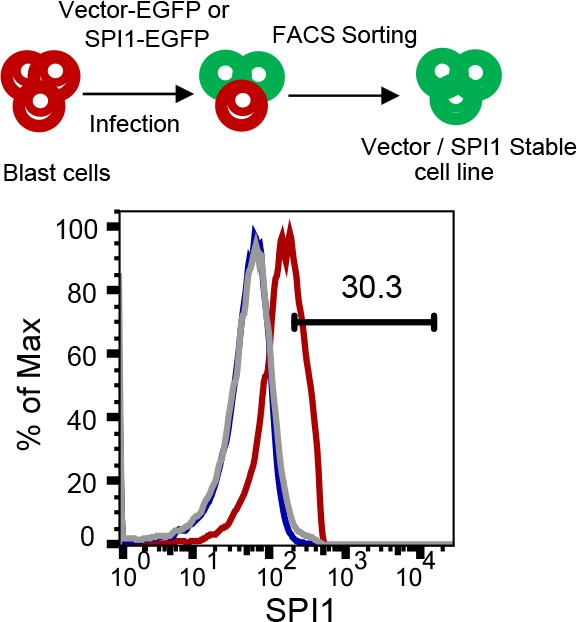
A schematic illustration of establishing lines expressing EGFP vector or EGFP-PU.1.Upper, a schematic illustration for establishing blast lines expressing the EGFP or EGFP-Spi1 vector; lower, FACS for intracellular SPI1 expression in blast cells infected with the empty EGFP retroviral vector (Blast-EGFP; blue) or the vector with EGFP-Spi1 cDNA (Blast –SPI1; red).